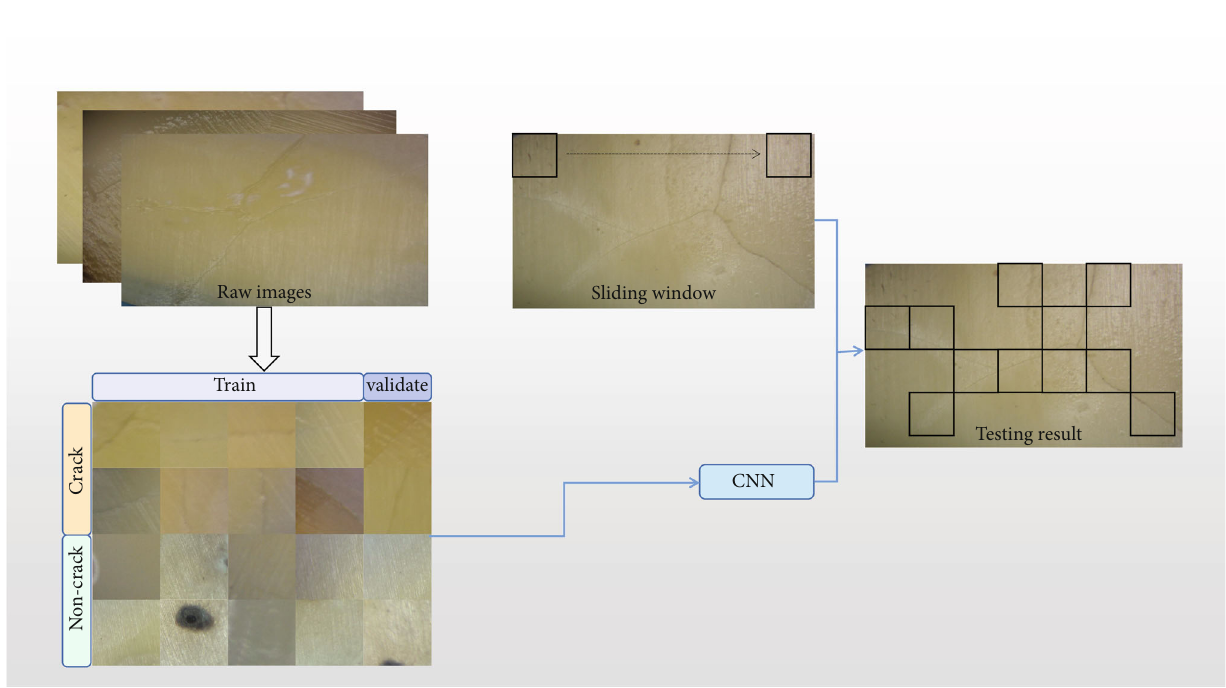
Figure 1: Flow chart for detecting cracks the proposed method. The trained CNN classi fi er ( 256 × 256 pixels) can e ff ectively identify the areas with or without cracks in raw images ( 1920 × 1080 pixels) by combining the sliding window